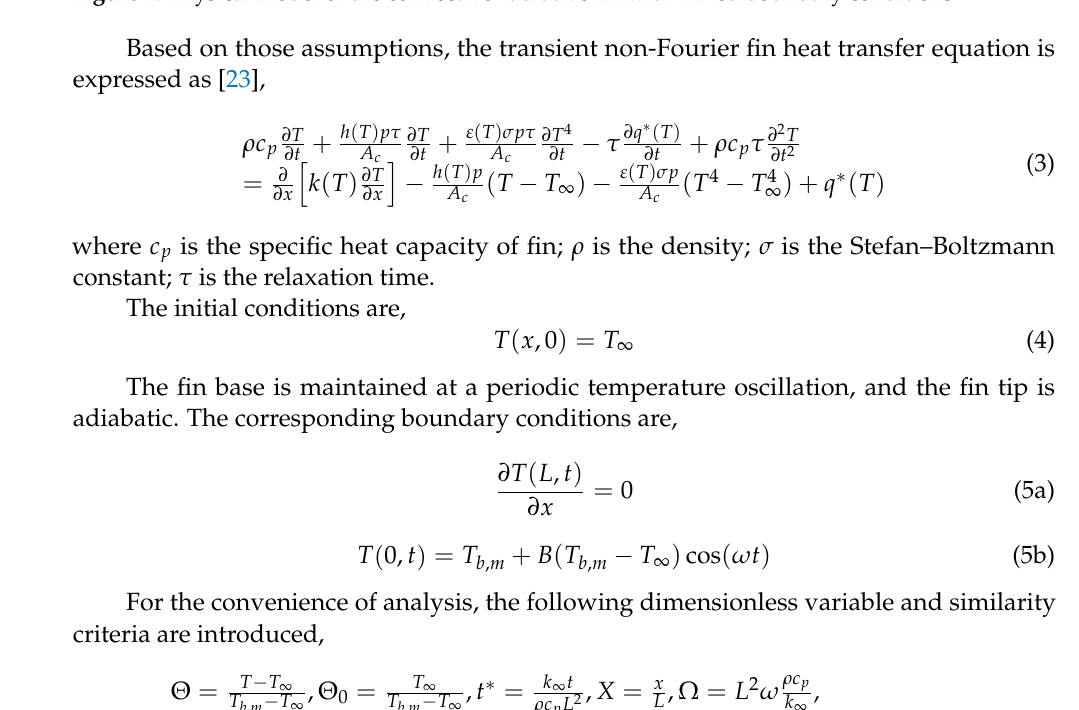
Figure 1. Physical model of the convective-radiative fin with mixed boundary